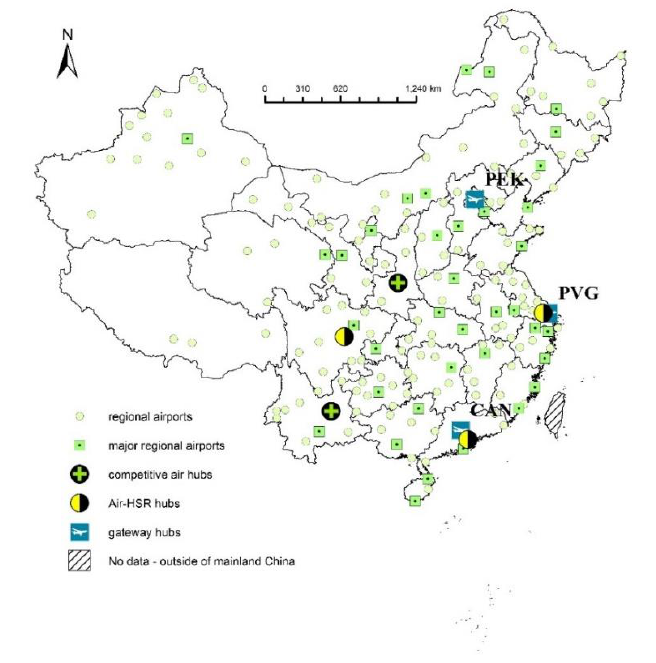
Figure 2. Airport partition with Air-HSR interaction in the 50km buffer